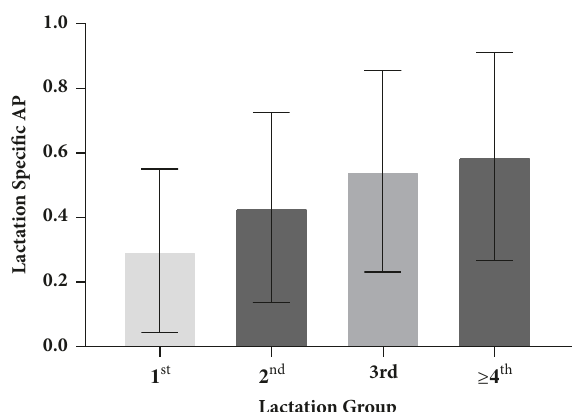
Figure 1: Mean lactation-specific APs with standard deviation bars by lactation group.